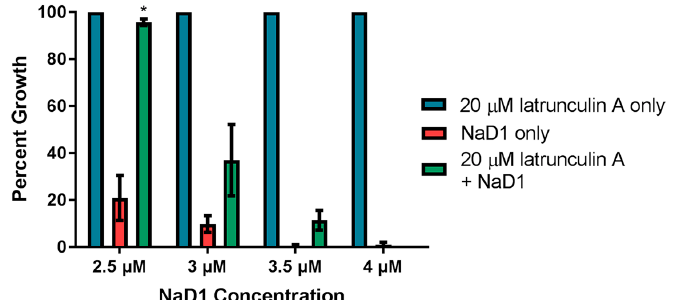
Figure 5. Latrunculin A reduces the inhibitory activity of NaD1 against C. albicans . C. albicans DAY185 was treated with 20 µ M latrunculin A only, NaD1 only or 20 µ M latrunculin A and NaD1 in combination. NaD1 was included at 2.5, 3, 3.5 and 4 µ M. Data are relative to the 20 µ M latrunculin A only control. Error bars represent standard error of the mean ( n = 3). Values marked by an asterisk are significantly different (using an independent t -test) to the NaD1 only control ( p -value < 0.05).